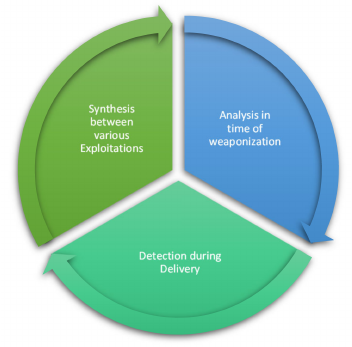
Figure 13. IoT botnet kill chain model for early